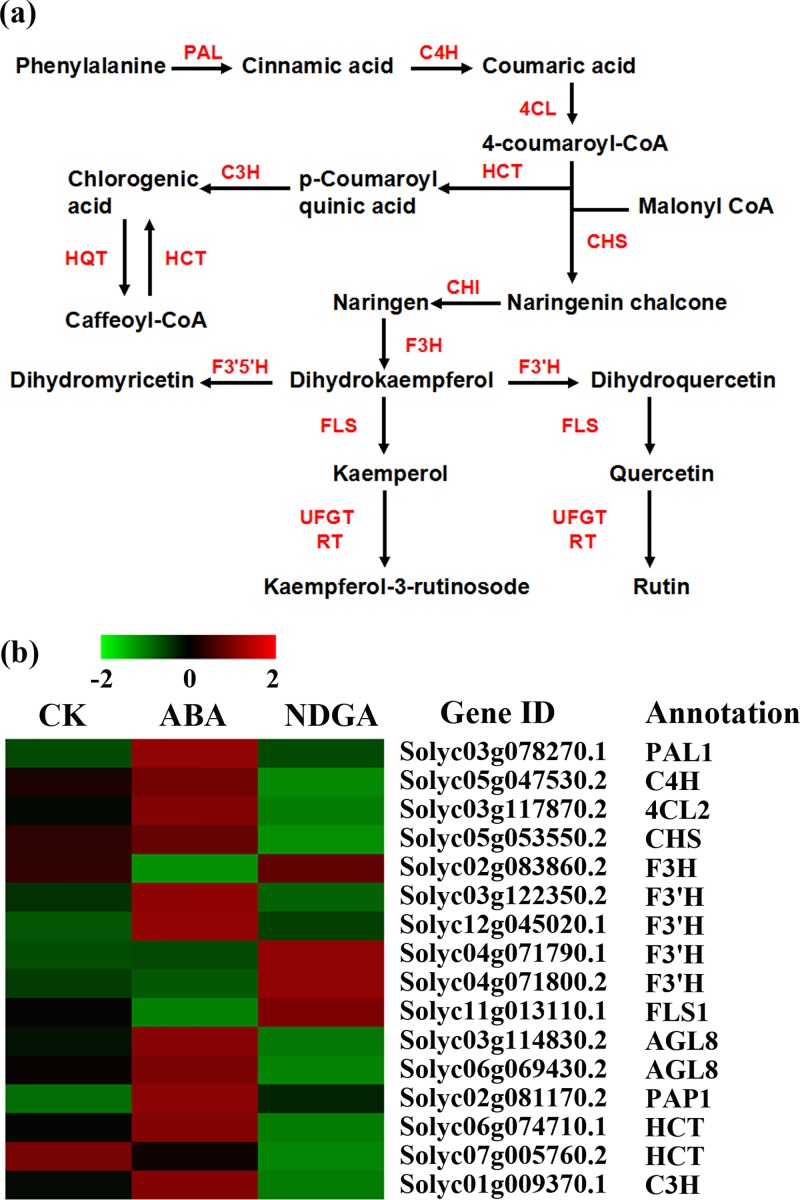
Analysis of DEGs involved in the pathway of flavonoids biosynthesis.(a) Schematic diagram of flavonoids biosynthesis (modified from the reference [49]). (b) The expression profile of 16 DEGs encoding key enzymes in the pathway. Abbreviations are listed in Supplemental S19 Table.